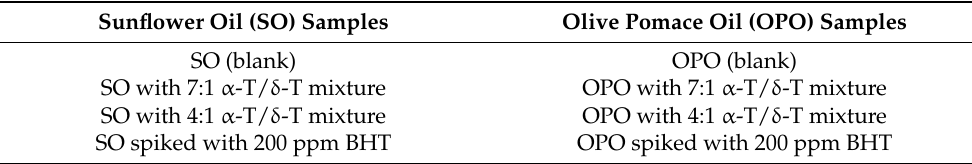
Table 10. Oil samples (blank and fortified) oxidized with the Rancimat. Sunflower Oil (SO) Samples Olive Pomace Oil (OPO) Samples SO (blank) OPO (blank) SO with 7:1 α -T/ δ -T mixture OPO with 7:1 α -T/ δ -T mixture SO with 4:1 α -T/ δ -T mixture OPO with 4:1 α -T/ δ -T mixture SO spiked with 200 ppm BHT OPO spiked with 200 ppm